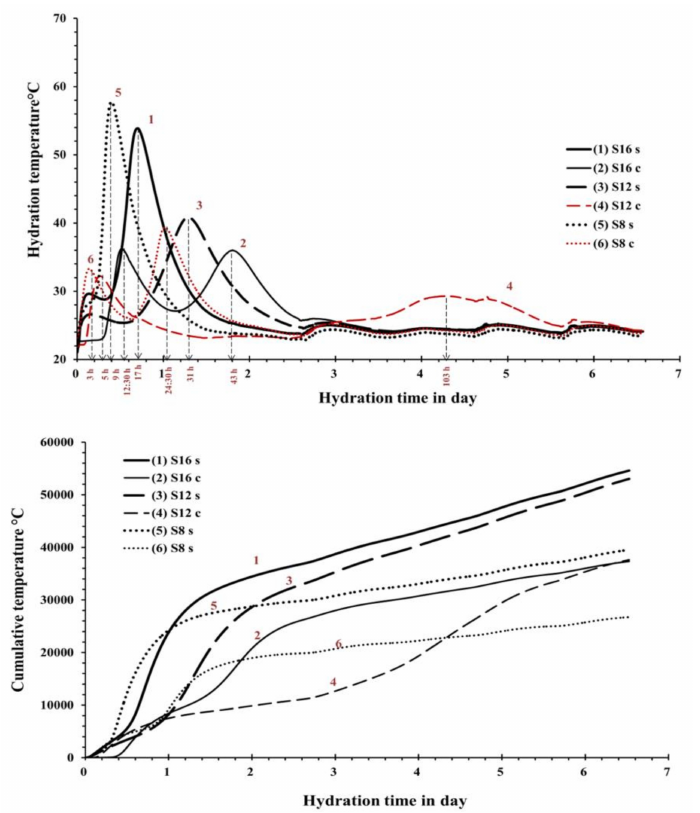
Figure 5. The hydration temperature peaks and the cumulative temperature of the AAS